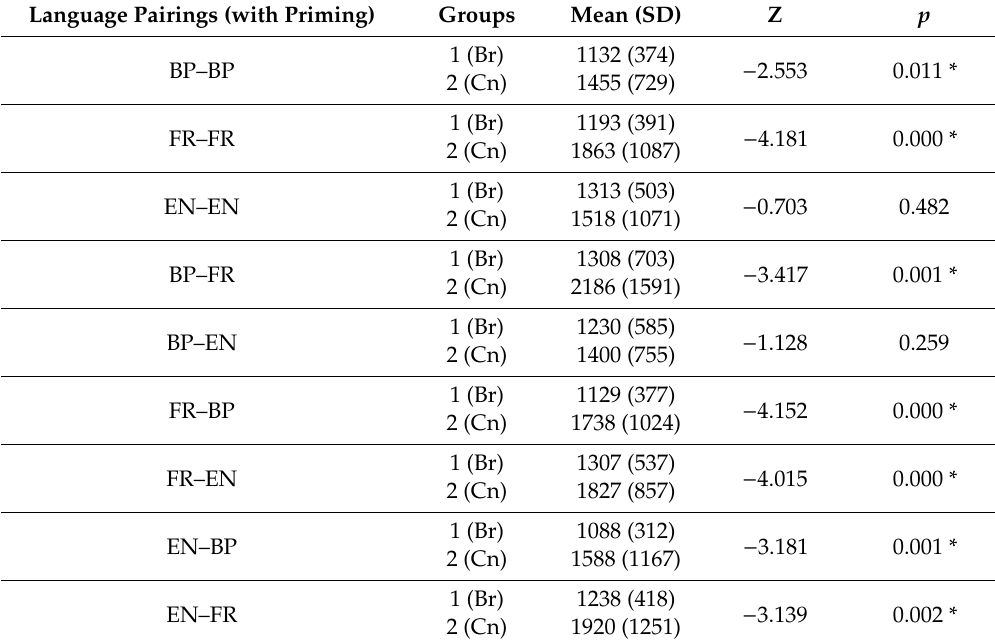
Table 5. Results for the comparison of combinations containing related